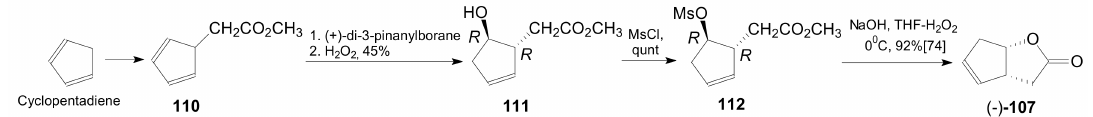
Scheme 23. Asymmetric synthesis of the optically active lactone ( − )-107 by reducing the double bond with (+)-di-3-